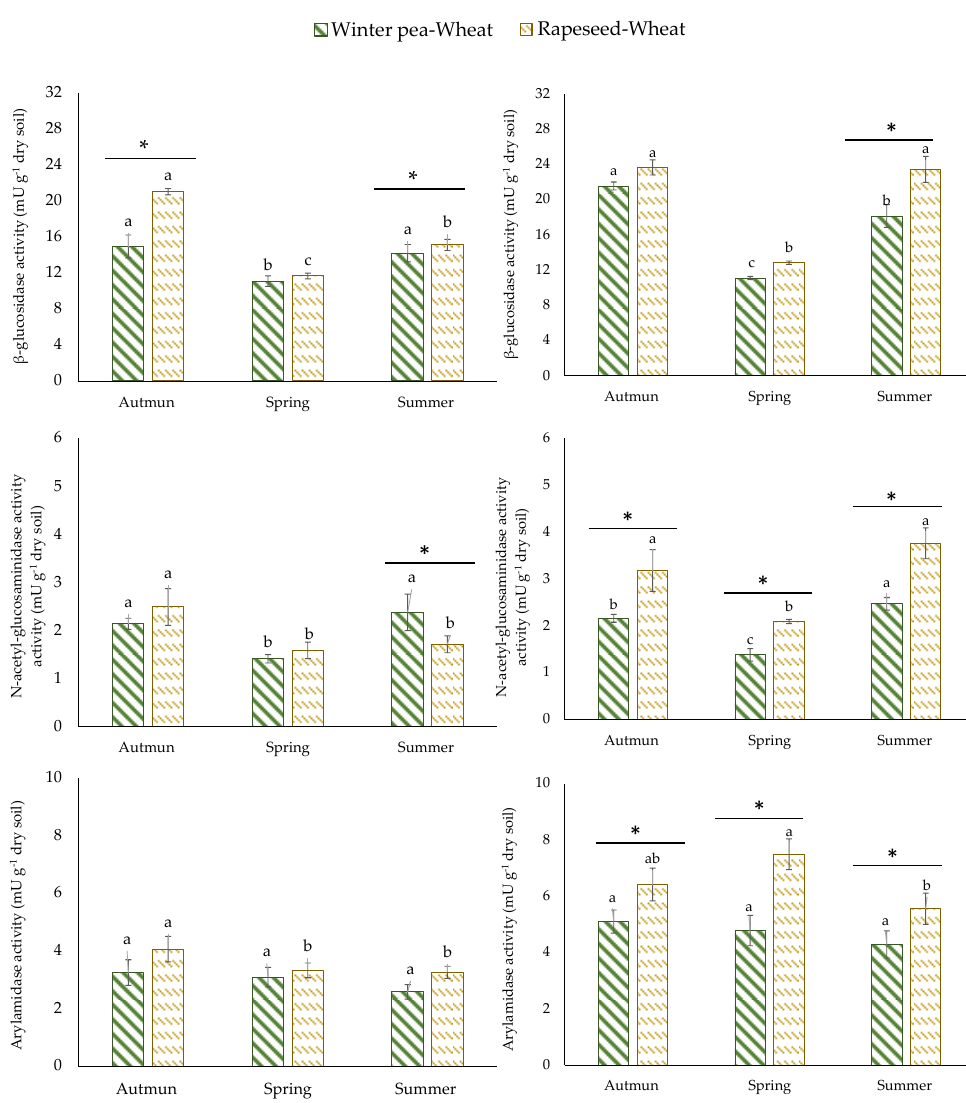
Figure 3. Enzyme activities in two crop successions (winter pea–wheat, rapeseed–wheat) at 3 sampling dates in the plot 1 ( a ) and plot 2 ( b ). Error bars on data points represent the standard errors of the mean of three replicates ( n = 3). Letters indicate statistical significance between the 3 sampling dates and asterisks indicate statistical significance between the two successions (pea–wheat vs. rapeseed–wheat) at p < 0.05 according to Tukey’s test.